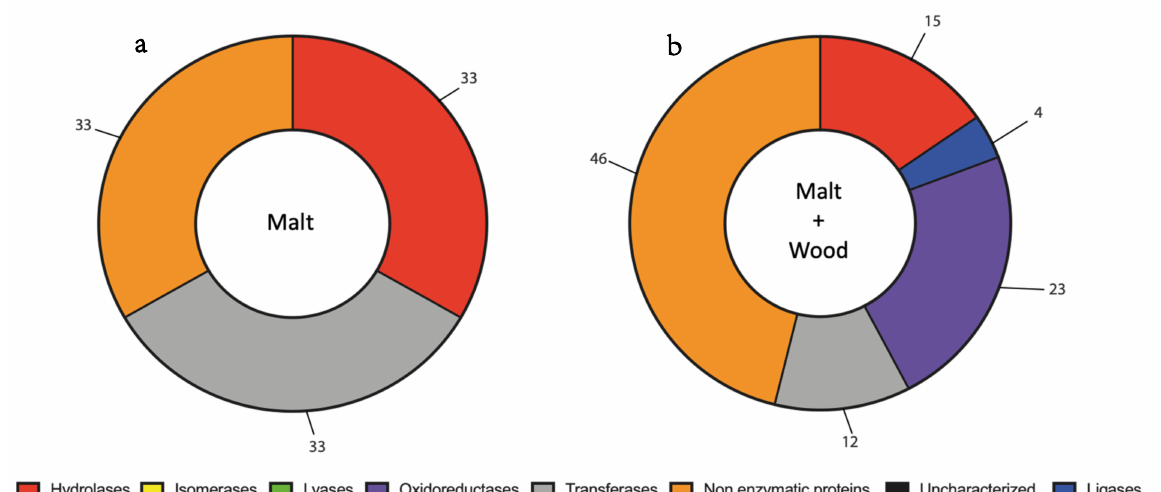
Figure 4. Classification of secreted protein based on molecular functions of D. seriata cultivated without ( a ) or with grapevine sawdust ( b ). The numbers are expressed in percentage of total proteins in each